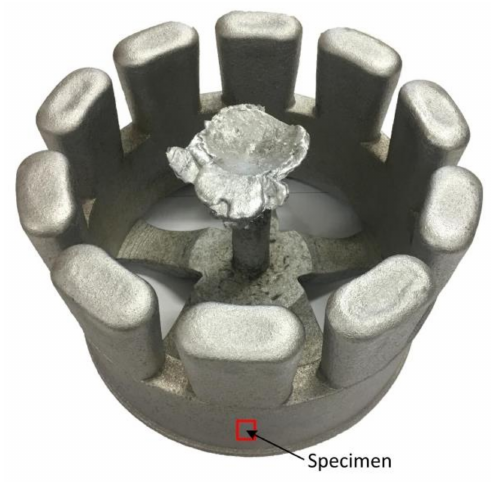
Figure 12. The casting obtained from the 3D-printed sand mold.